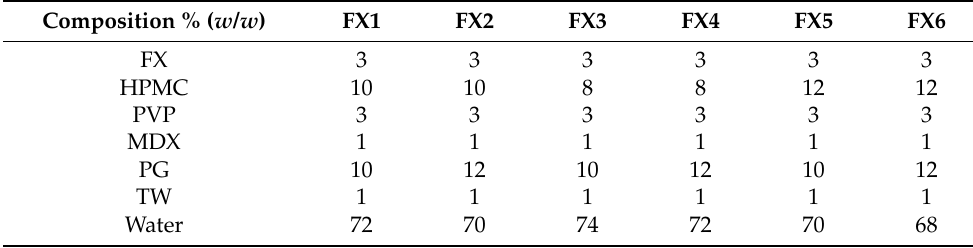
Table 2. Orodispersible films with